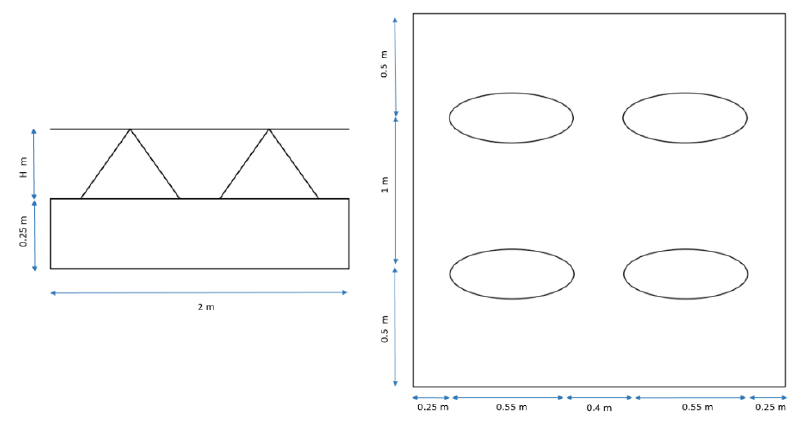
Figure 2. Sprayer distribution in pond 2.